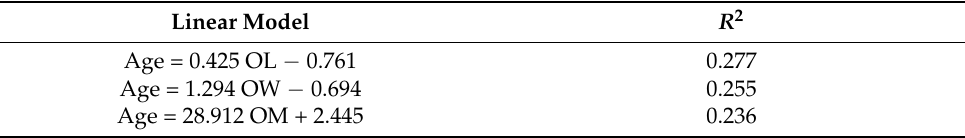
Figure 4. Fitted von Bertalanffy growth curve of the European barracuda, Sphyraena sphyraena , in the eastern Adriatic. Table 4. Relationships between observed fish age and otolith morphometrics (OL = otolith length, OW = otolith width, OM = otolith mass) of the European barracuda, Sphyraena sphyraena , in the eastern Adriatic, described using the linear model (age = a (otolith morphometric) + b ); R 2 = coefficient of determination.